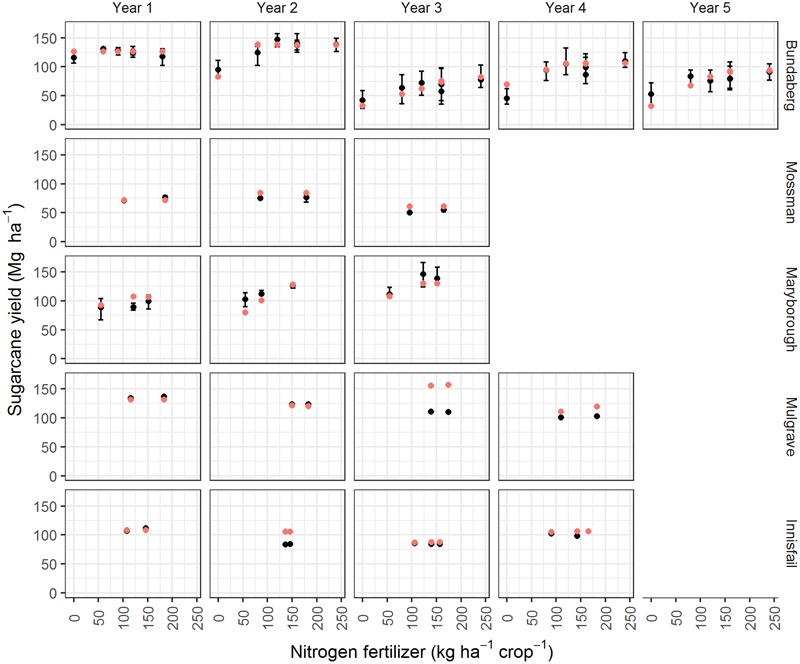
Measured (solid black points show the mean yield and “error bars” show the range of the replicates) and predicted (solid red points) sugarcane yields for five N response experiments (Table 1) conducted over 3–5 years. The experiments commenced in the following years: 1996 for Bundaberg; 2003 for Mossman; and 2004 for Maryborough, Mulgrave, and Innisfail.